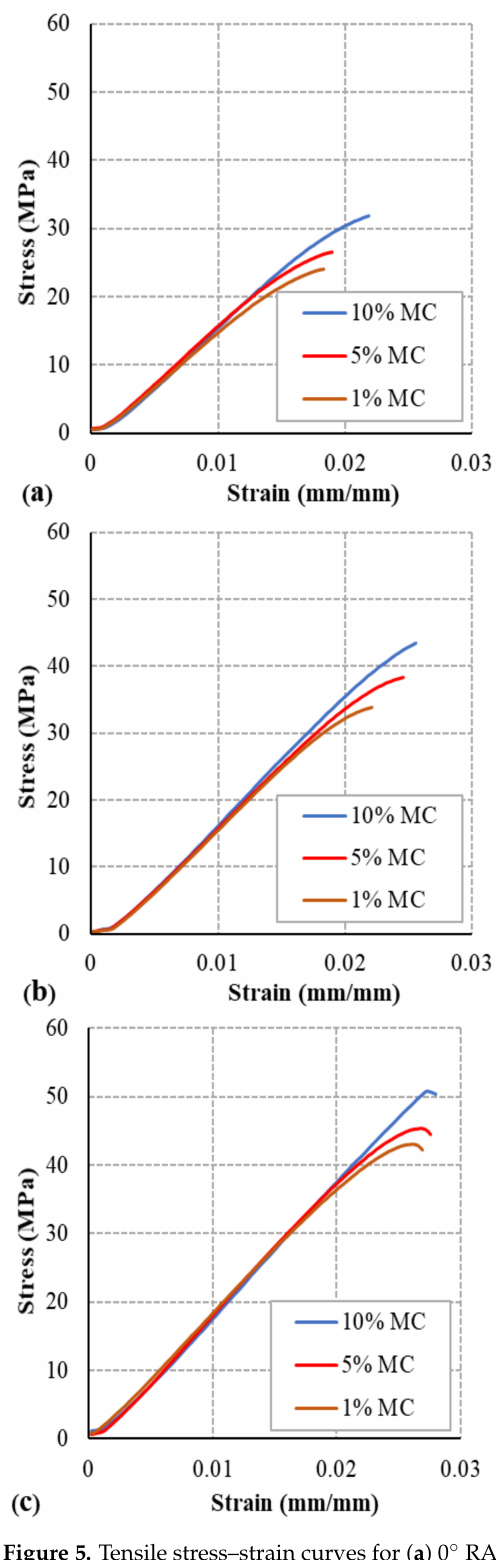
Figure 5. Tensile stress–strain curves for ( a ) 0 ◦ RA, ( b ) 45 ◦ RA, and ( c ) 90 ◦